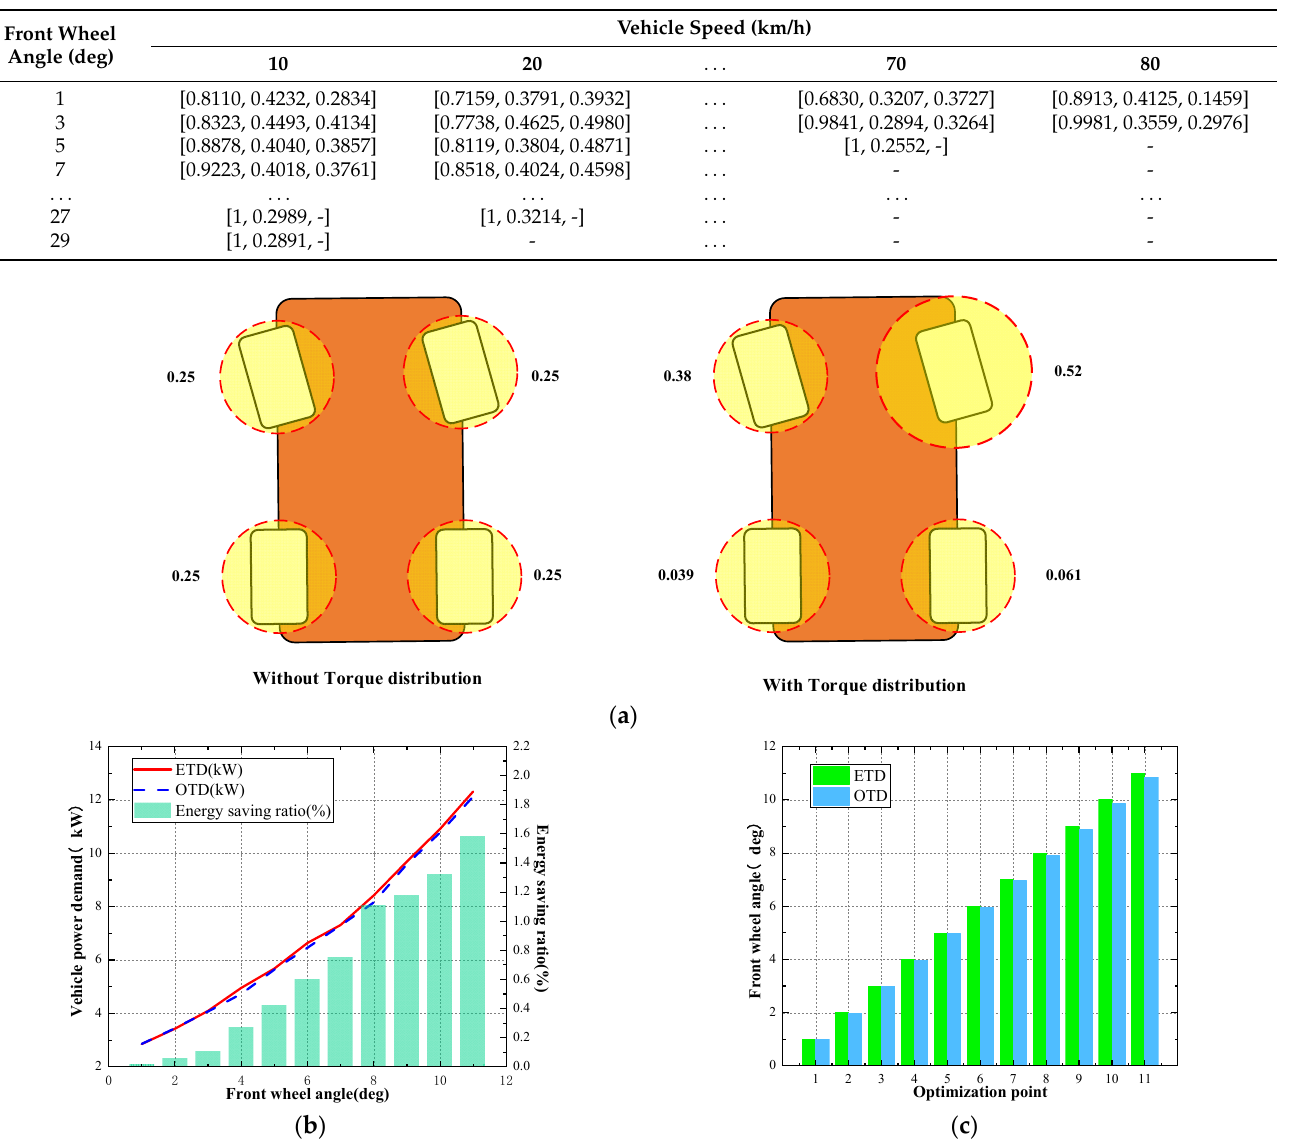
Figure 6. ( a ) 40 km/h, 3° front wheel angle; ( b ) optimized energy consumption diagram at 40 km/h; ( c ) optimize the distribution of front and rear wheel angles at 40 km/h.